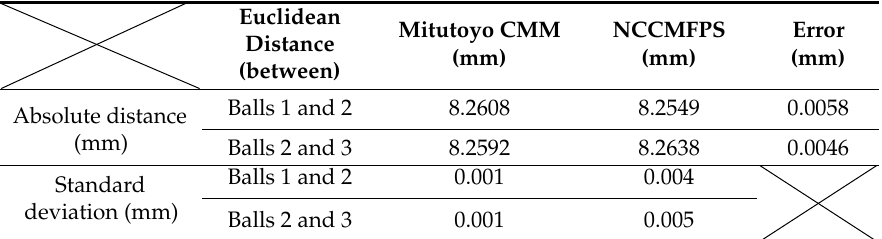
Figure 13. Measured 3D profile of step-height target: ( a ) 3D profile; ( b ) detected ball centers in ( a ); ( c ) 3D profile measured using MFPS; and ( d ) 3D profile measured using NCCMFPS. Table 2. Comparison of distances between ball centers measured using NCCMFPS and the Mitutoyo